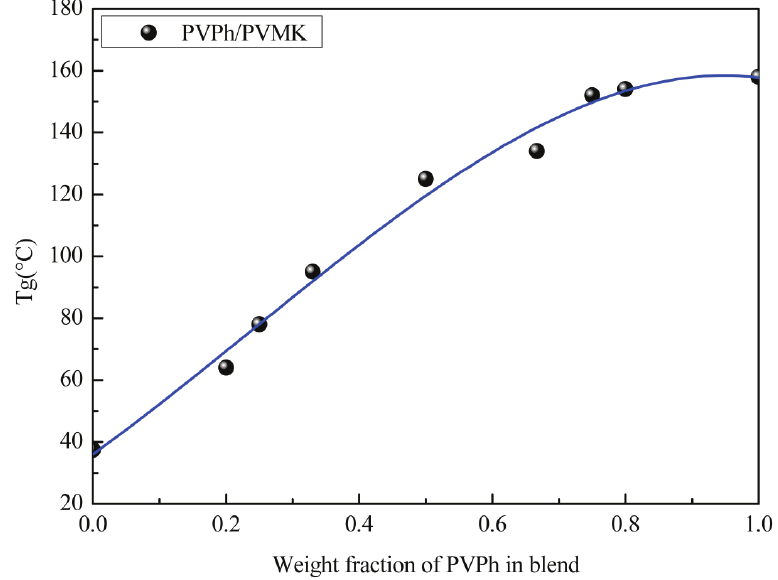
Figure 2. T g -composition variation versus PVPh weight fraction of the PVPh/PVMK